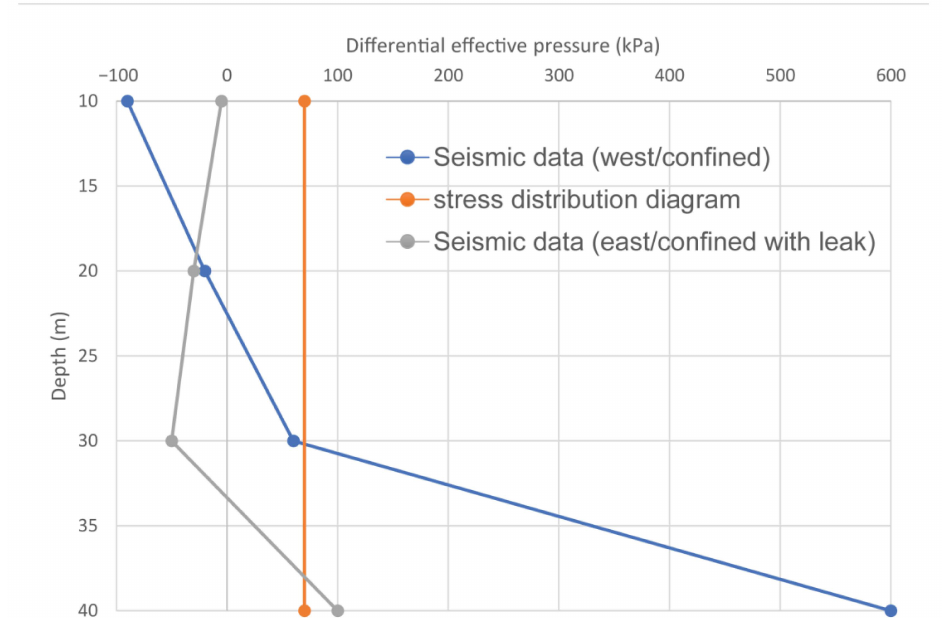
Figure 14. Comparison of differential effective pressure from the stress distribution diagram derived (Figure 13c) and from differential effective pressure from the shear-wave seismic velocity data (Figures 10c and 11c).